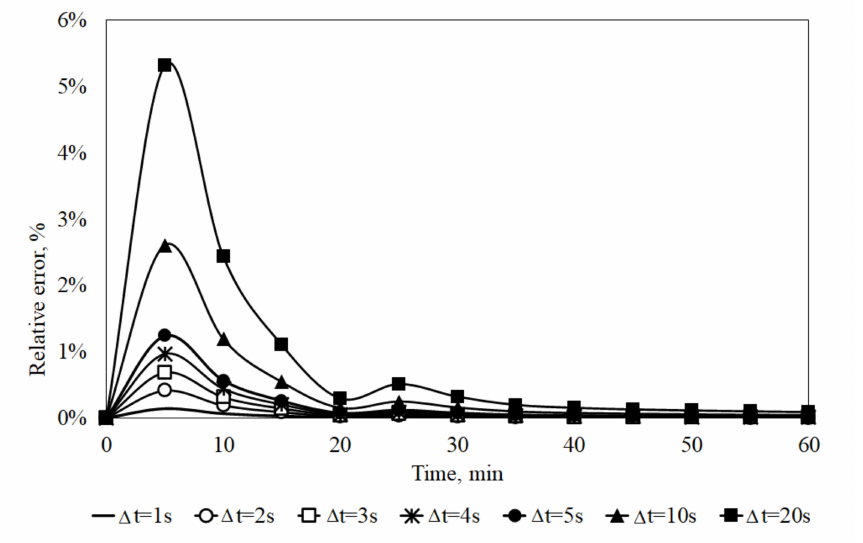
Figure 4. Relative error for the use of EC3 method,